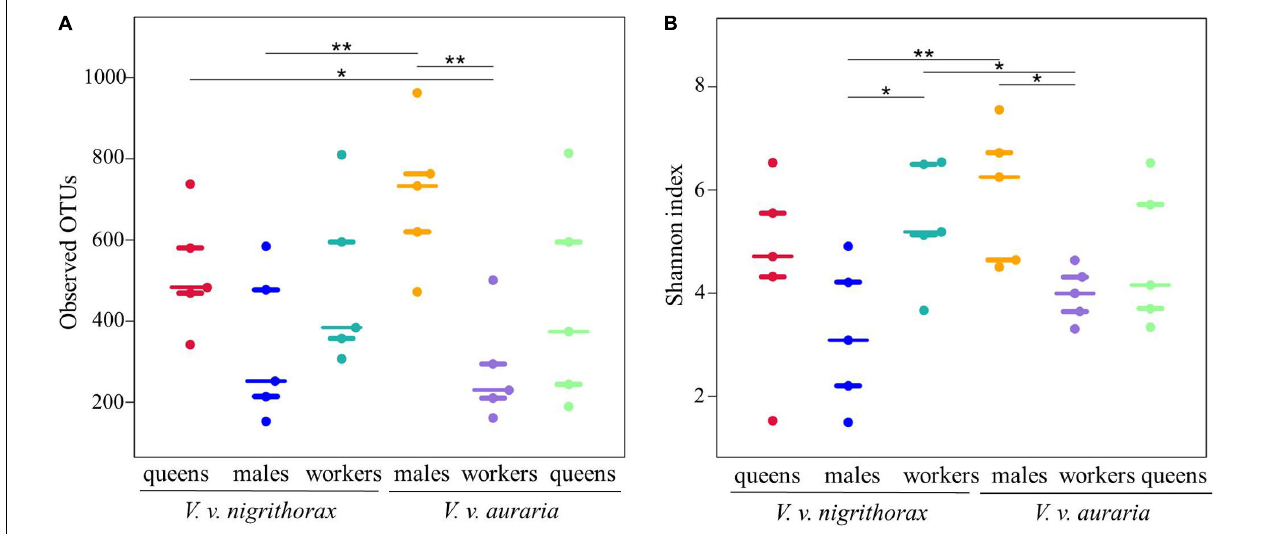
FIGURE 1 | Alpha diversity in Vespa velutina nigrithorax and Vespa velutina auraria midgut bacteria. (A) The amount of bacterial diversity was determined by comparing observed operational taxonomic units (OTUs) and (B) Shannon index. “*” indicates significance at the 0.05 level, and “**” indicates significance at the 0.01 level.